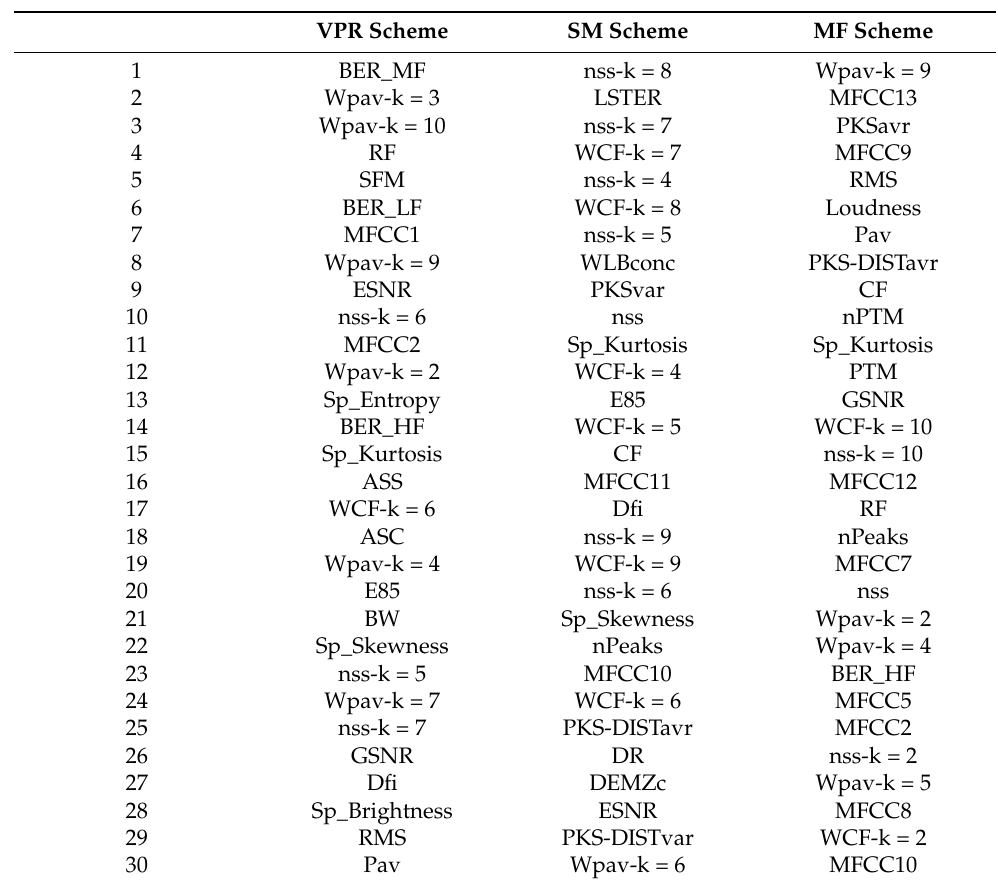
Figure 3. Extracted feature set. Table 2. Feature